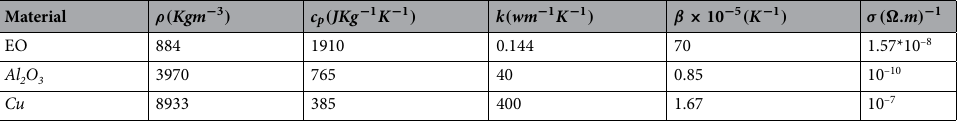
Table 1. Thermal properties of base fluid (EO), and nano-meter sized particles ( Cu) and (Al 2 O 3 ) are given in refs. 11, 61 .